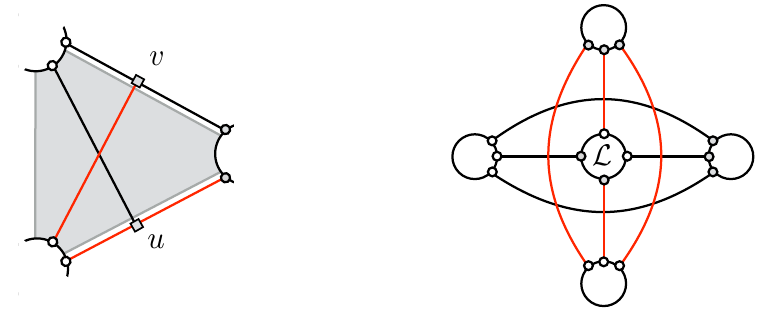
Figure 20 . In the left panel, we show an exotic form factor with two scalars of di(cid:11)erent (cid:13)avours along the edges of a hexagon. The right panel displays a 5pt function obtained by inserting the dilaton in the (cid:12)shnet 4pt function. We could factorise it using the hexagon form factors constructed in this paper by telling the magnonic story all the way from the bottom to the top. The exotic form factors would provide an alternative representation, where the hexagons are glued all around the dilaton, making the crossing symmetry